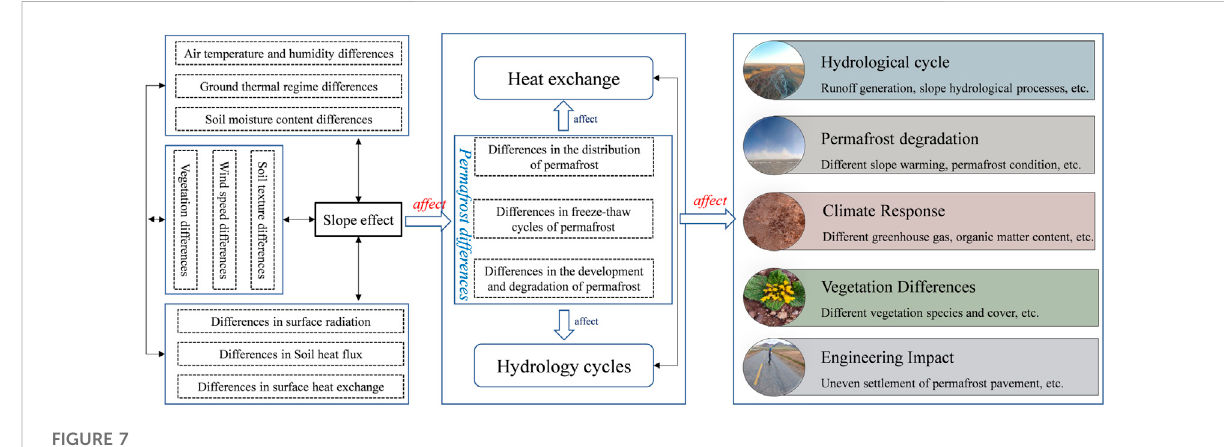
FIGURE 7 Environmental effects of high-altitude permafrost region under slope